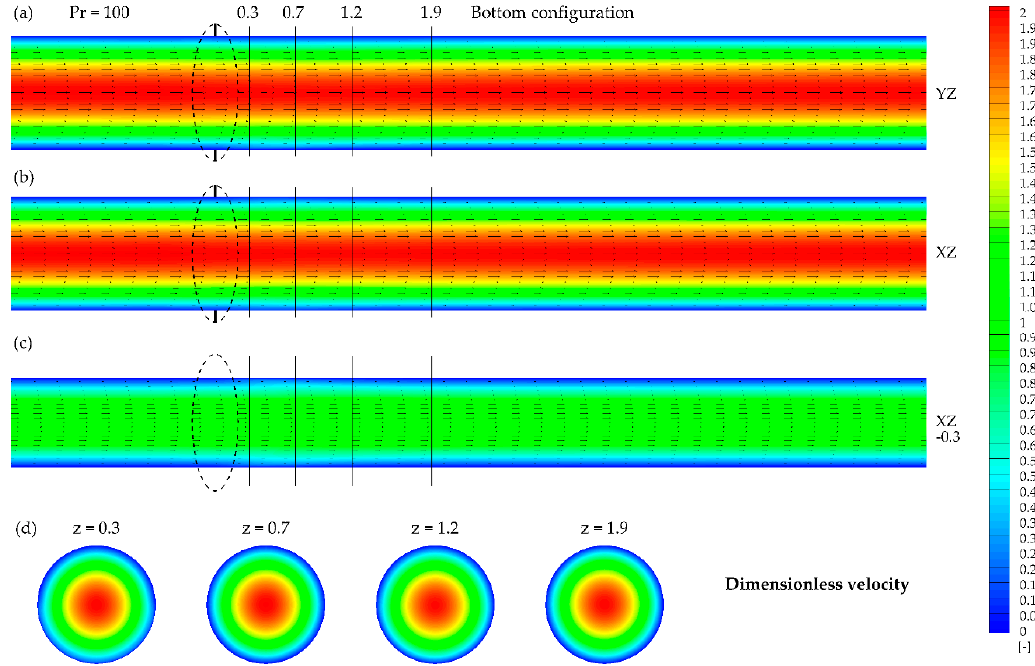
Figure 9. Dimensionless velocity contours and vectors obtained for Pr = 100 and bottom configuration in the presence of the magnetic field at: ( a ) YZ plane, ( b ) XZ plane, ( c ) XZ plane ( y = − 0.3), ( d ) XY planes at given z .